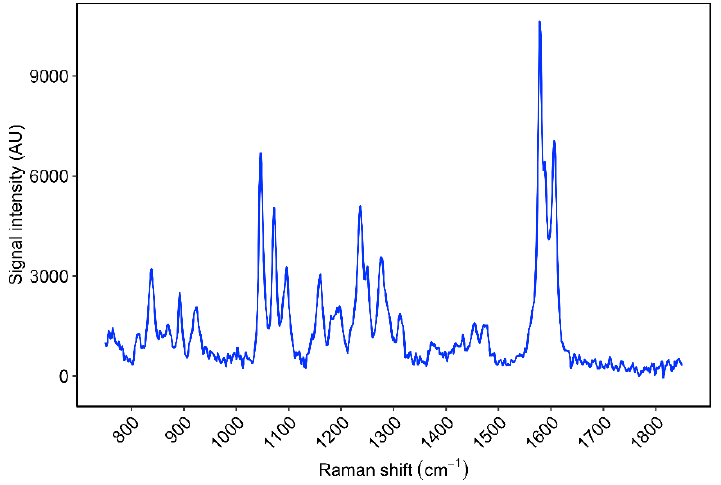
Figure 2. Reference Raman spectrum of DFNa in PG solution (200 mg/mL), using a 10 s exposure time, mean of 10 frames.